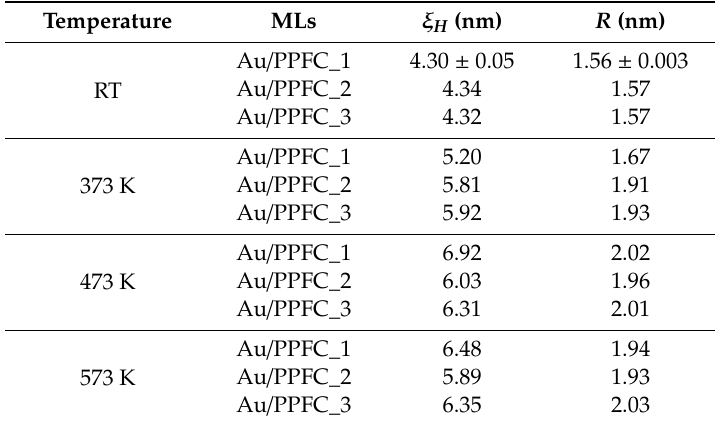
Table 3. NPs radius ( R ) and interparticle distance ( ξ H ) variation in three MLs with varying temperature. The values for the errors given in row 1 hold for all values in the columns.